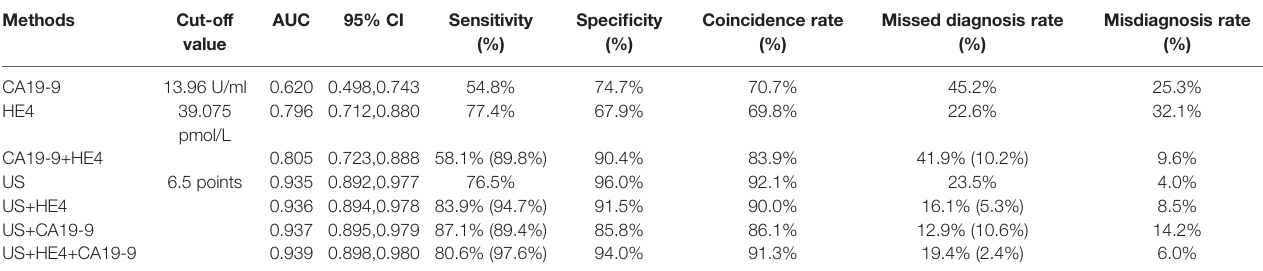
TABLE 7 | The ROC curve analysis values of each diagnostic method and the diagnostic value of parallel test in combined screening (the values in brackets are the diagnostic indicators of parallel tests). Methods